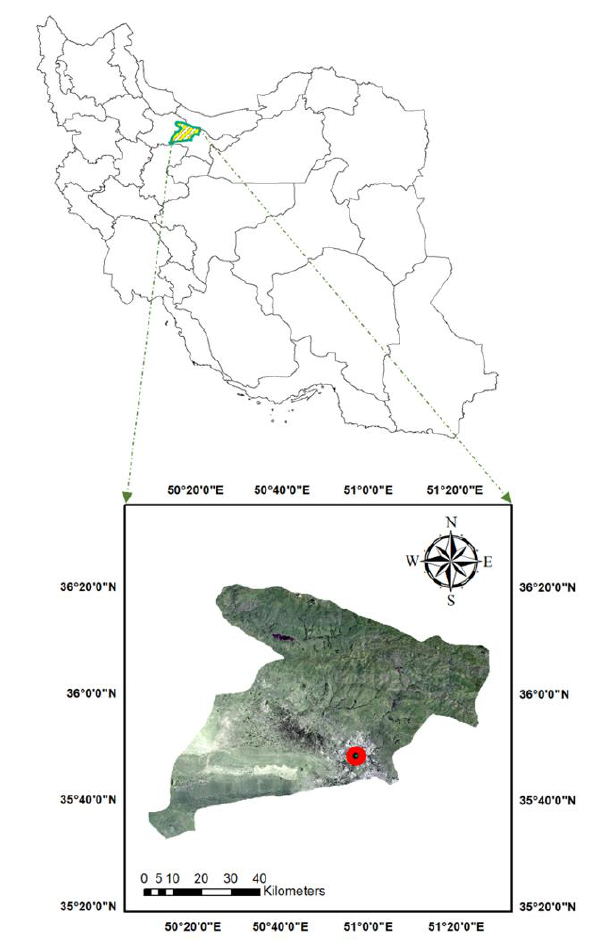
Figure 1 . Location of sample points and the study region